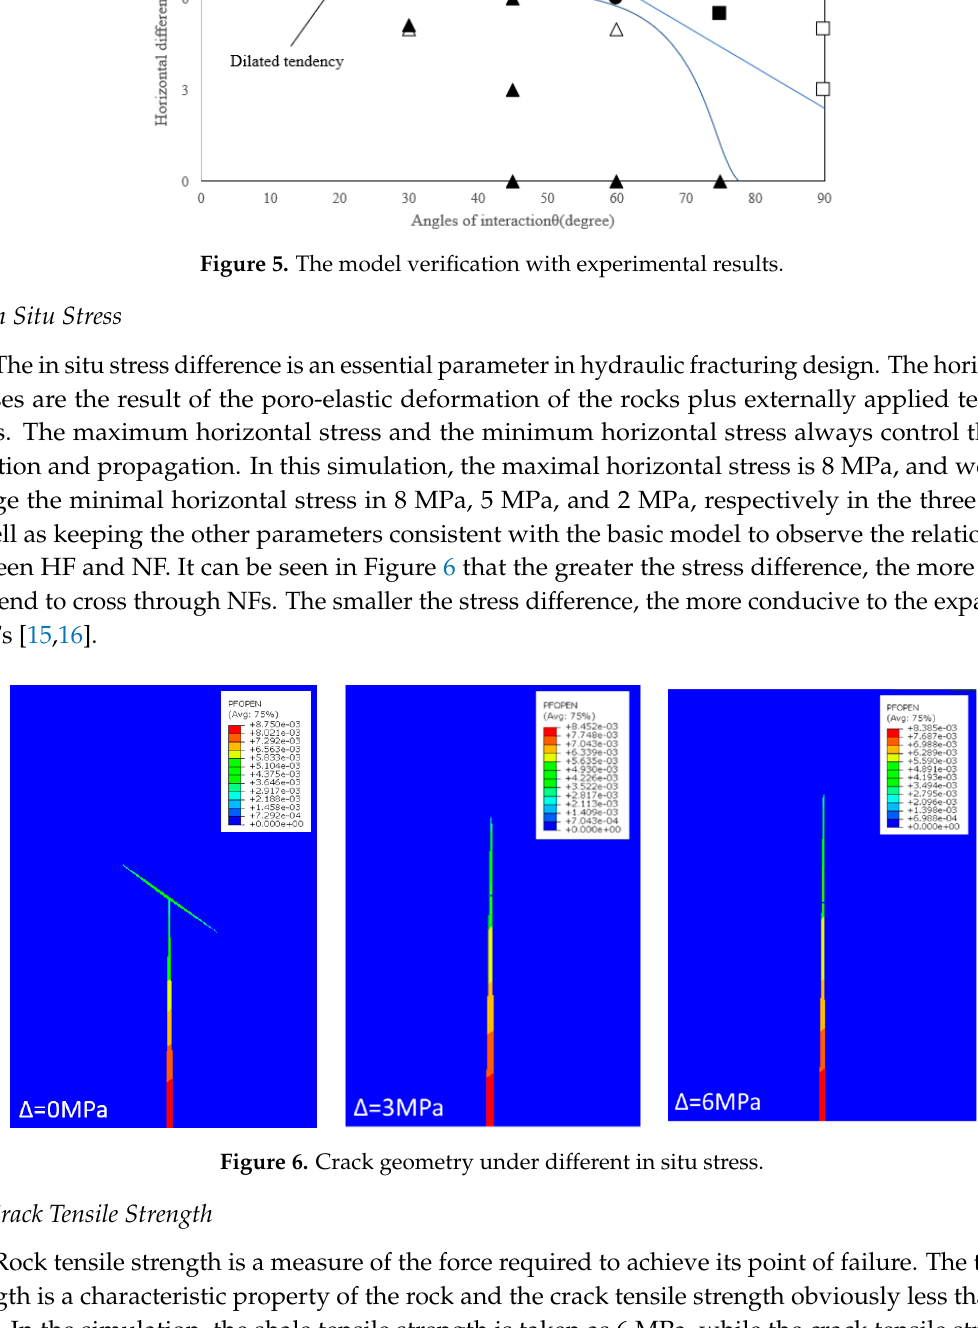
Figure 7. Crack geometry in difference tensile strength. 4.4. Fracturing Fluid Injection Rate Injection rates have a great impact on fracture geometry, as shown in Figure 8, and they influence fracture patterns. In this simulation, the fracturing fluid injection rate is taken as 3 m 3 /min, 6 m 3 /min, and 12 m 3 /min. The crack geometries of the three examples are described in Figure 8. When the injection rate is high, HF is more likely to cross NFs, and at the same time fill the entire crack. This increases not only the fracture length but also the fracture width when increasing the fracturing fluid injection rate.